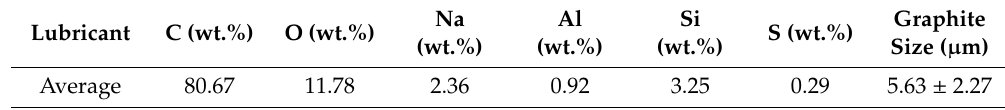
Figure 1. ( a ) Graphite-based lubricant matrix and ( b ) the kinematic viscosity curve of the water diluted lubricant. Table 1. Chemical composition and particle size of the graphite particles.